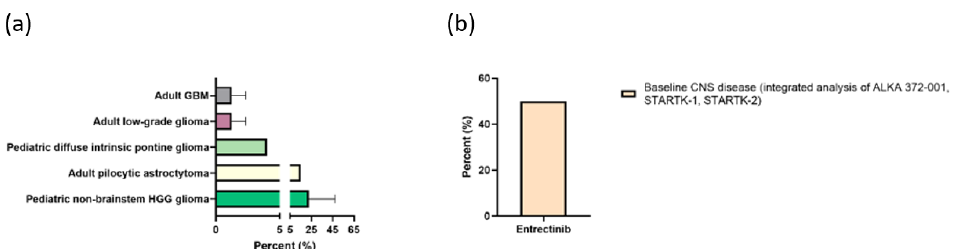
Figure 3. ( a ) Prevalence of Neurotrophic Tyrosine Receptor Kinase (NTRK) fusions in adult and paediatric gliomas; ( b ) response rates of entrectinib monotherapy (ALKA 372-001, STARTK-1; STARTK-2, NCT02650401).